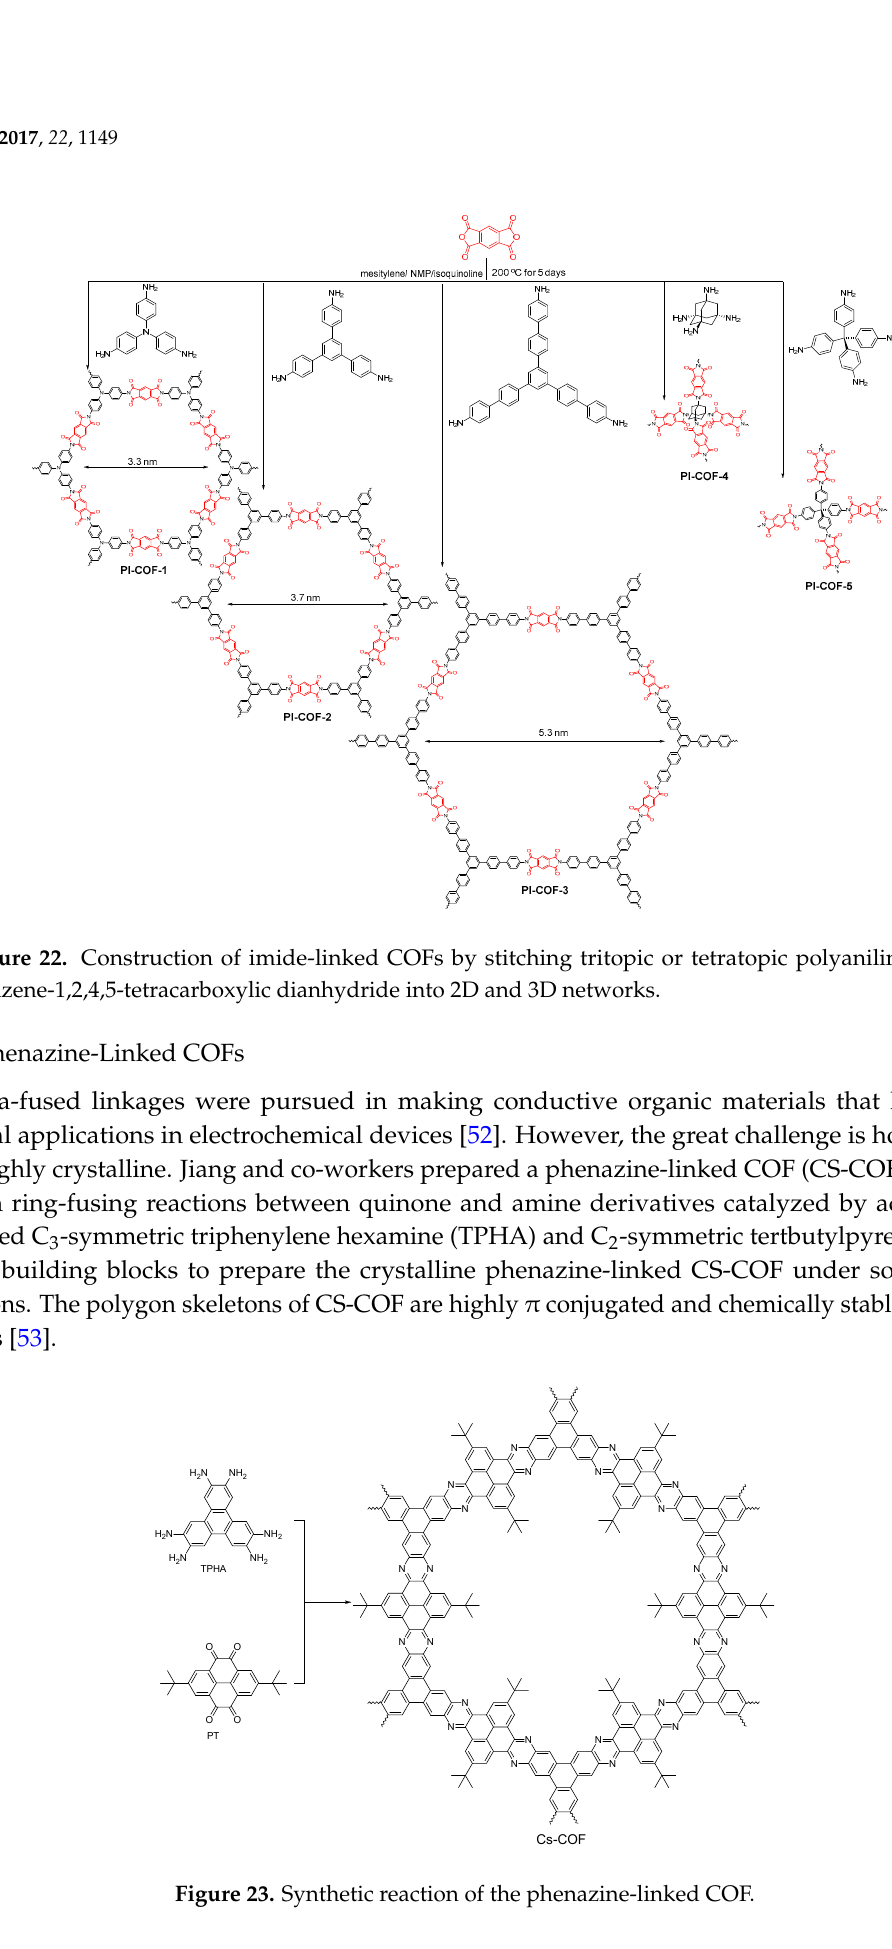
Figure 21. Synthetic reaction of squaraine-linked COFs (CuP-SQ COF).